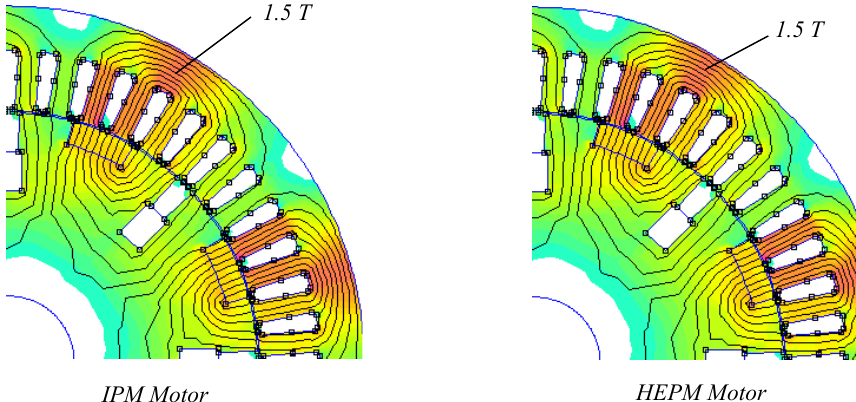
Figure 7. Torque and Power versus speed behaviors of the HEPM and IPM motors.